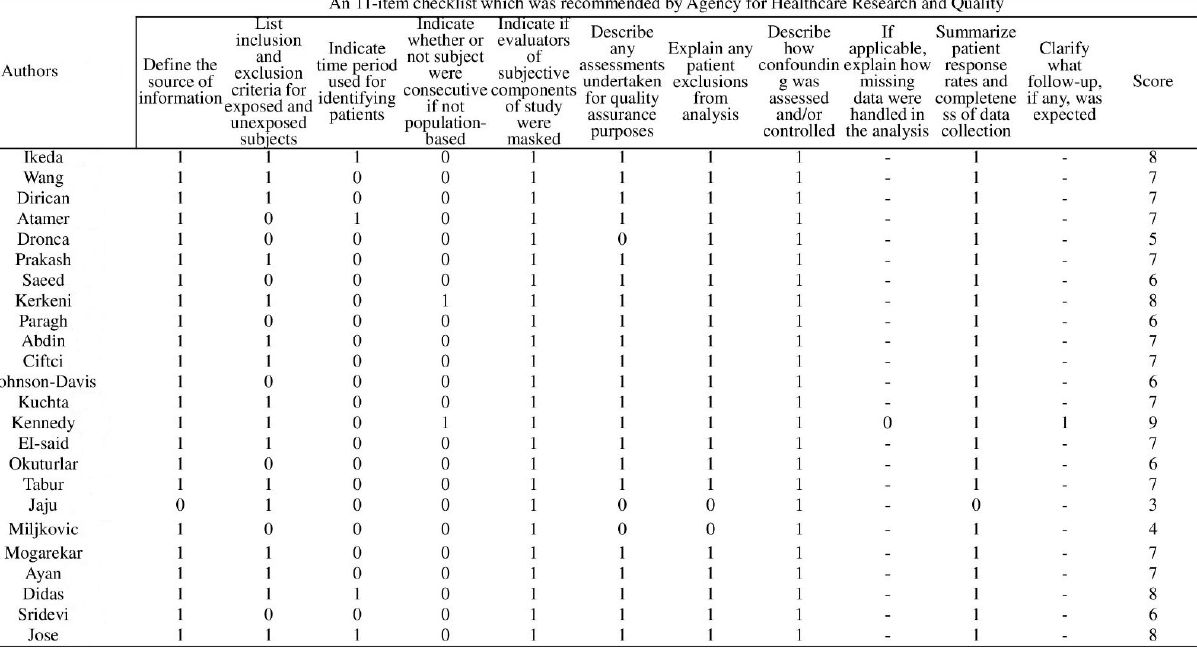
Figure A2. Forest plot of paraoxonase activity stratified by diabetes status [26–42,44,46–49].